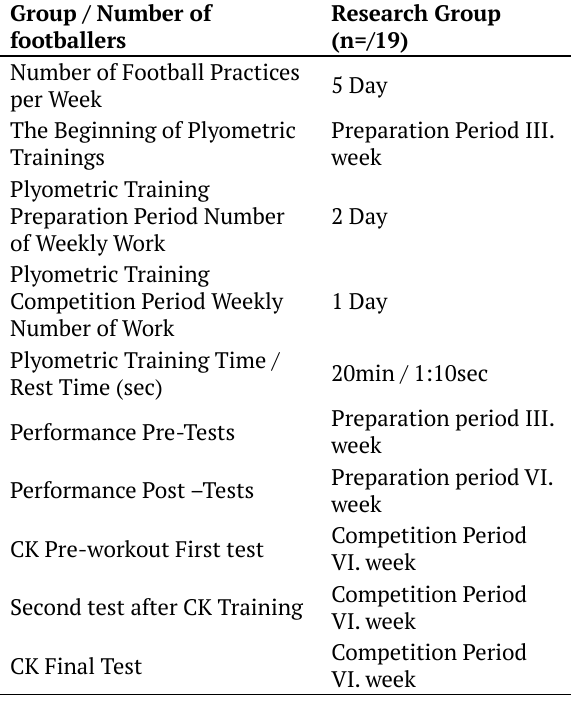
Table2. Footballers plyometric work design